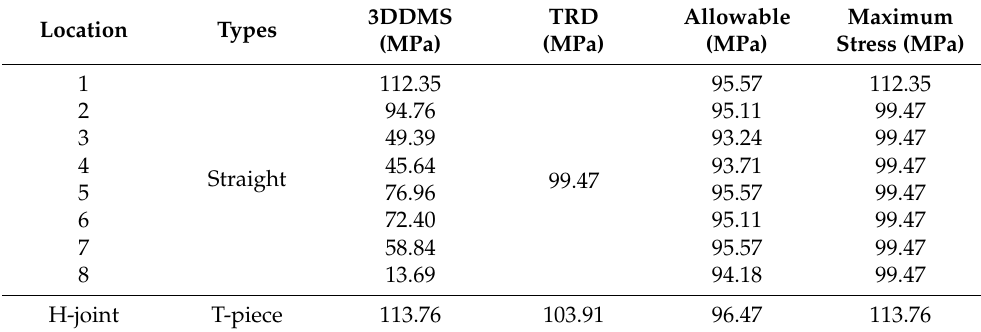
Table 5. Results of the stress calculation evaluated by three different methods.